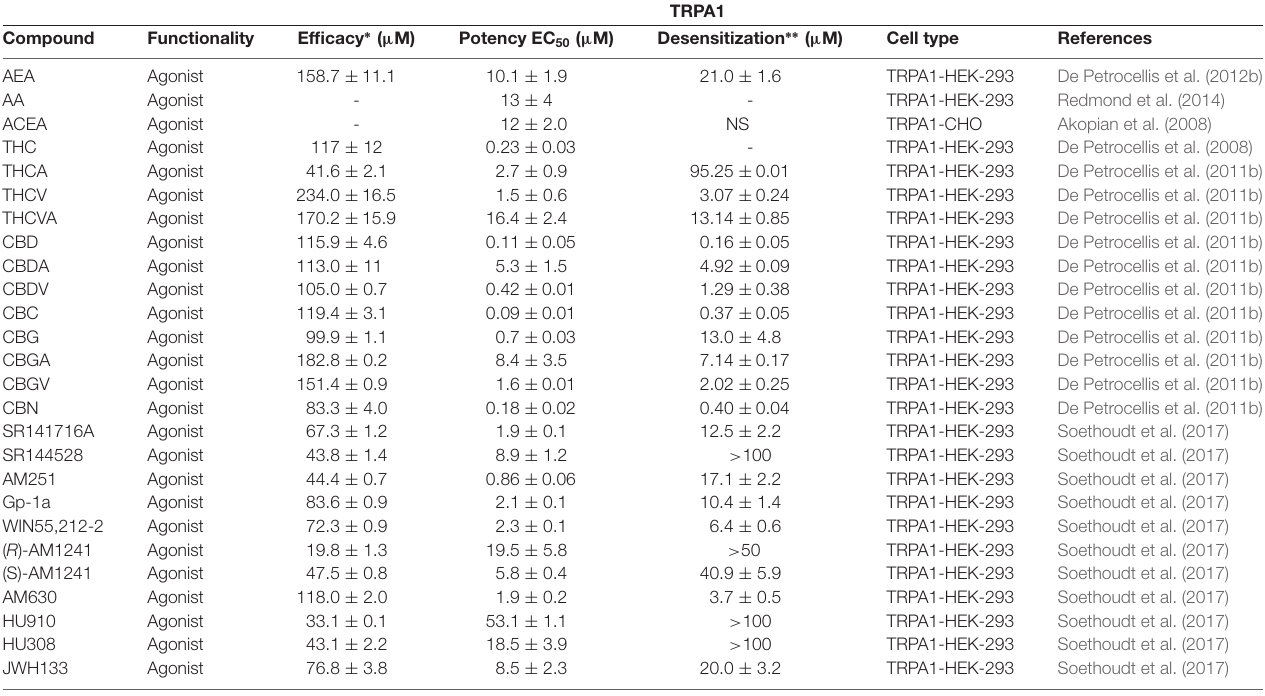
TABLE 5 | Functionality of phytogenic, endogenous, and synthetic cannabinoid ligands at TRPA1.